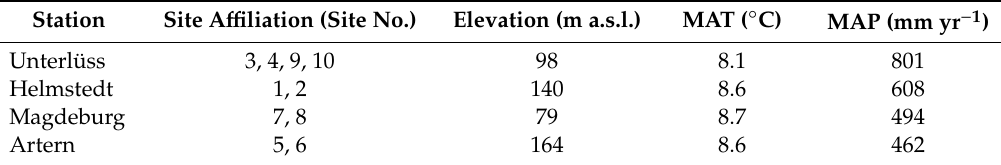
Table 4. Climate data of the six climate stations in the neighborhood of the study sites. Station Site A ffi liation (Site No.) Elevation (m a.s.l.) MAT ( ◦ C) MAP (mm yr − 1 ) Unterlüss 3, 4, 9, 10 98 8.1 801 Helmstedt 1, 2 140 Magdeburg 7,